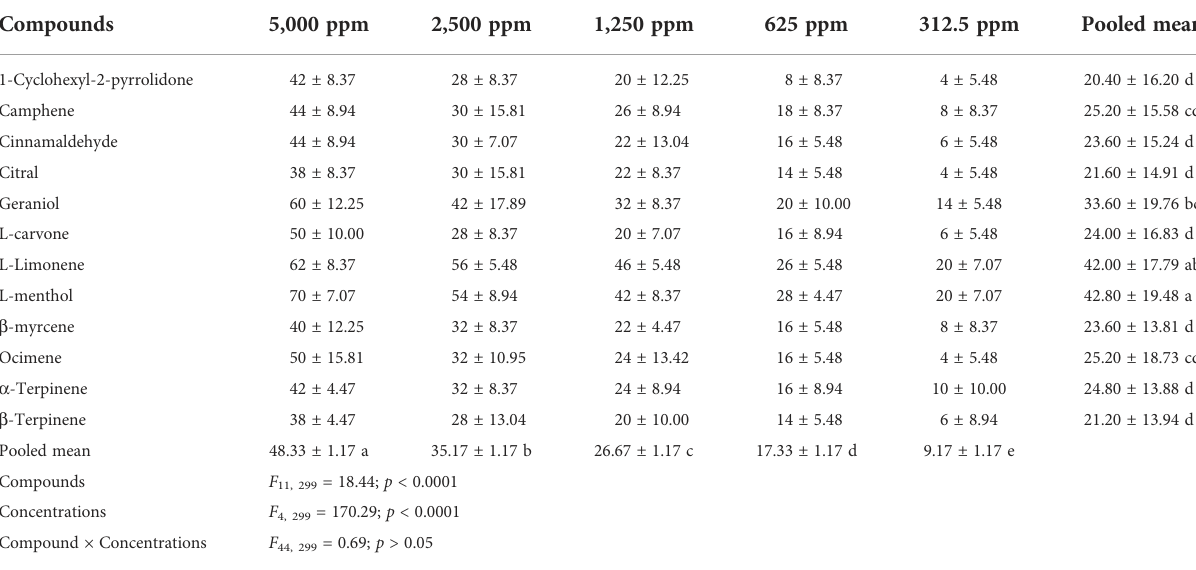
TABLE 3 Toxicity effect of various compounds against the second instar crawlers of P. lilacinus .